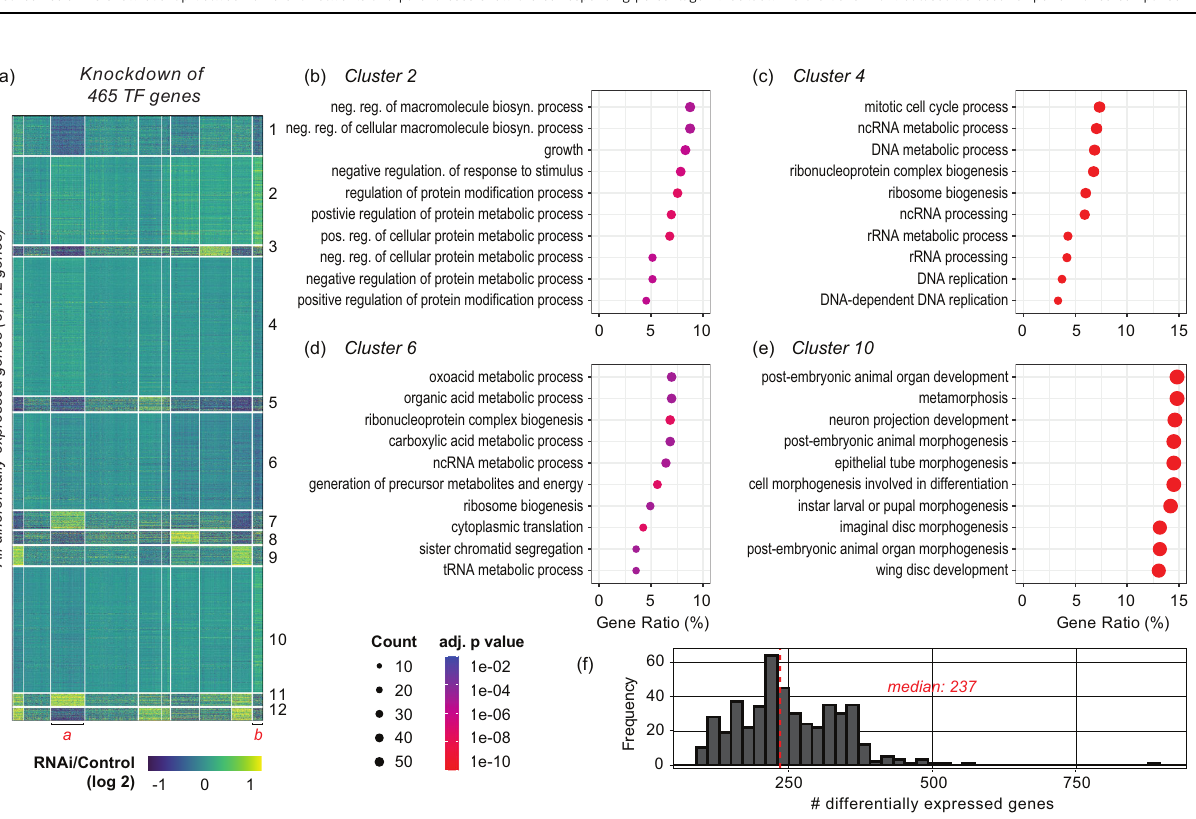
The last four columns show overlap between different networks and parentheses show the corresponding percentage. Knockdown is the benchmark dataset we used for performance comparison.